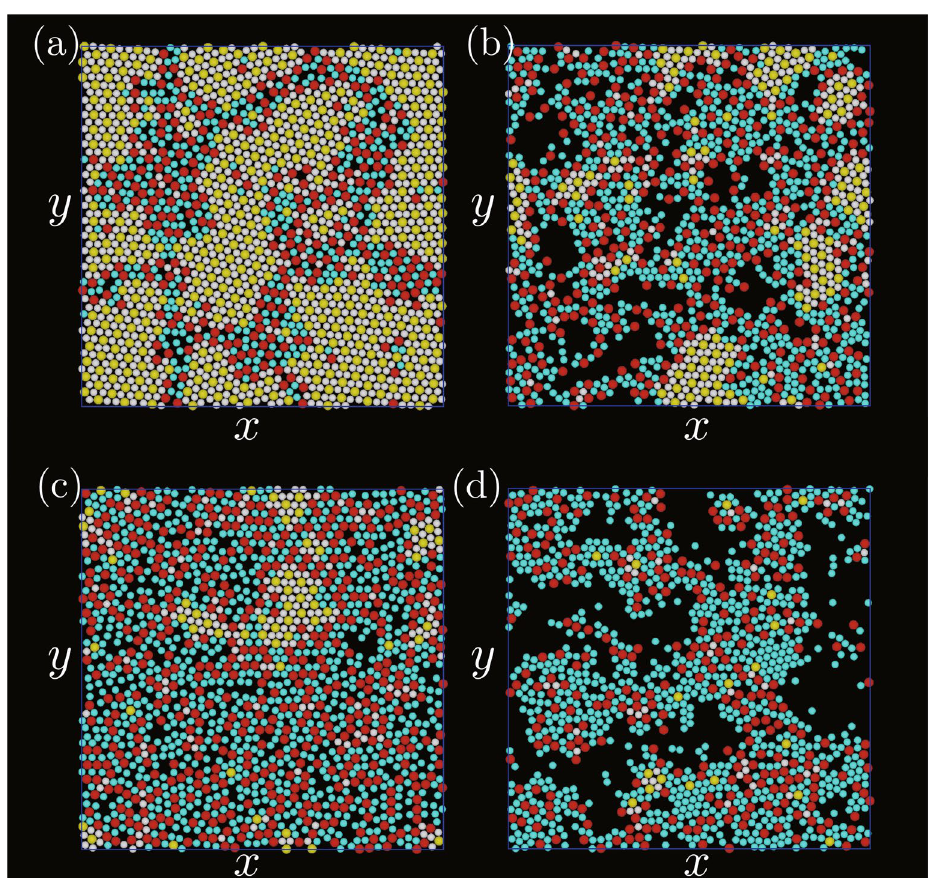
Figure 1. Snapshots of two-dimensional structures created on the bottom wall. ε AA /ε AB and ε BB /ε AB were ( a ) 0.1 and 0.1, ( b ) 0.1 and 0.8, ( c ) 0.8 and 0.1, and ( d ) 0.8 and 0.8. Yellow particles are A particles with φ B 6 > 0.7 ; white particles are B particles with φ A 3 > 0.7 ; red particles are A particles with φ B 6 < 0.7 ; cyan particles are B particles with φ A 3 < 0.7